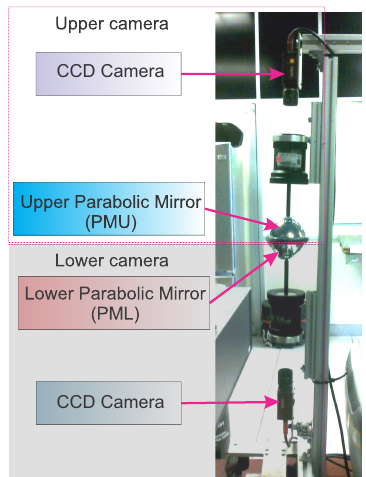
Figure 1. Panoramic 3D reconstruction system formed by two catadioptric cameras (upper camera and lower camera), each composed by a parabolic mirror and a Marlin F-080c